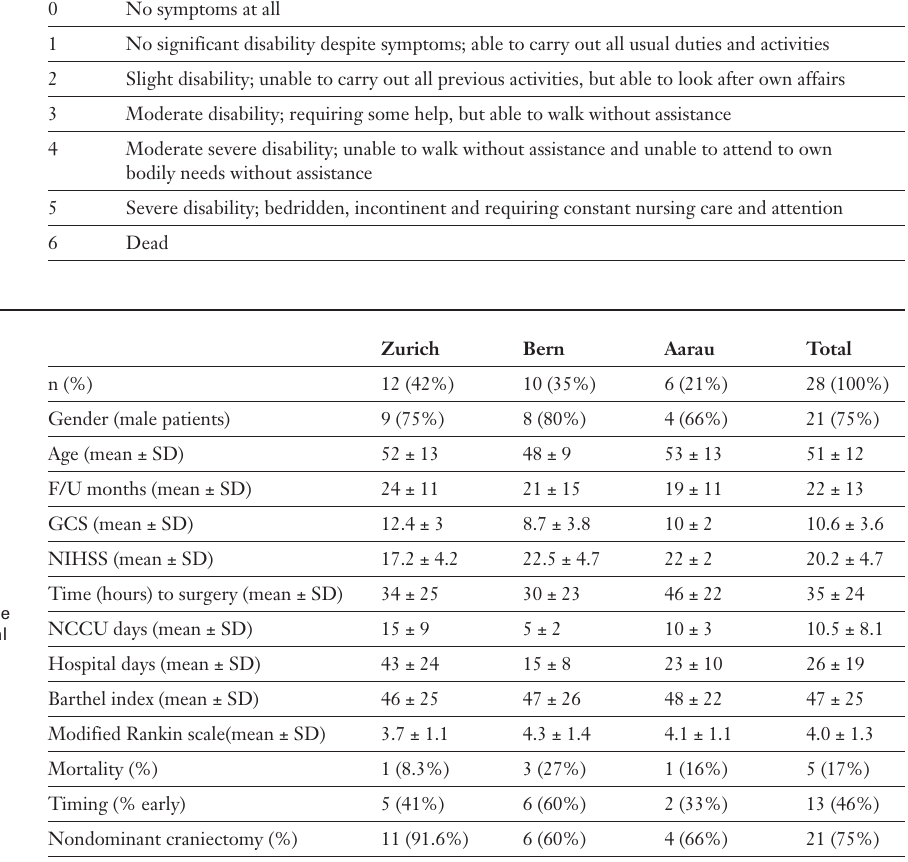
Doppler sonography, magnetic resonance imaging (MR),